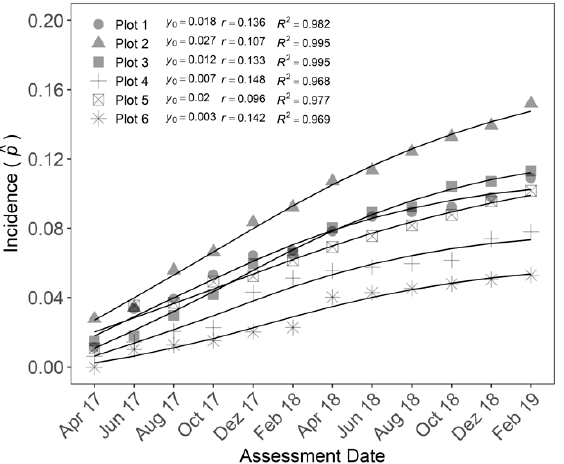
Figure 7. The Gompertz model adjusted to incidence data of Fusarium wilt of banana (FWB) from April 2017 to February 2019 in six plots located in Teixeiras, Minas Gerais, Brazil. Symbols represent the observed incidence in proportion ( 𝑝̂ ) and solid lines are the predicted incidence of FWB by the Gompertz model.